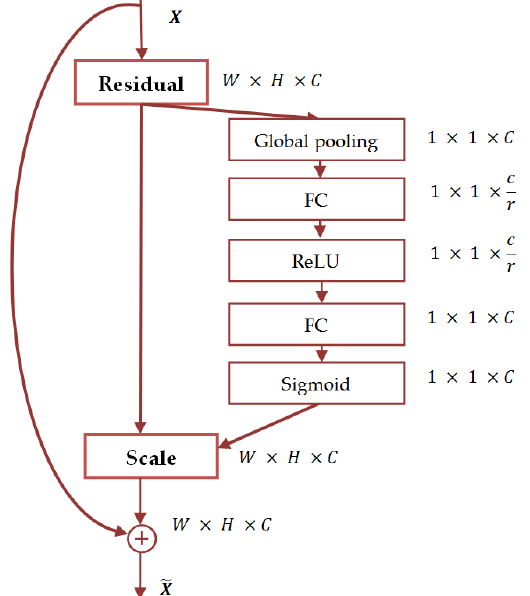
Figure 27. SENet architecture . X : the input. W × H : spatial dimensions. C : channel descriptor. r : reduction ratio. FC: fully connected layers. 𝑋̅ ̂ : the output.